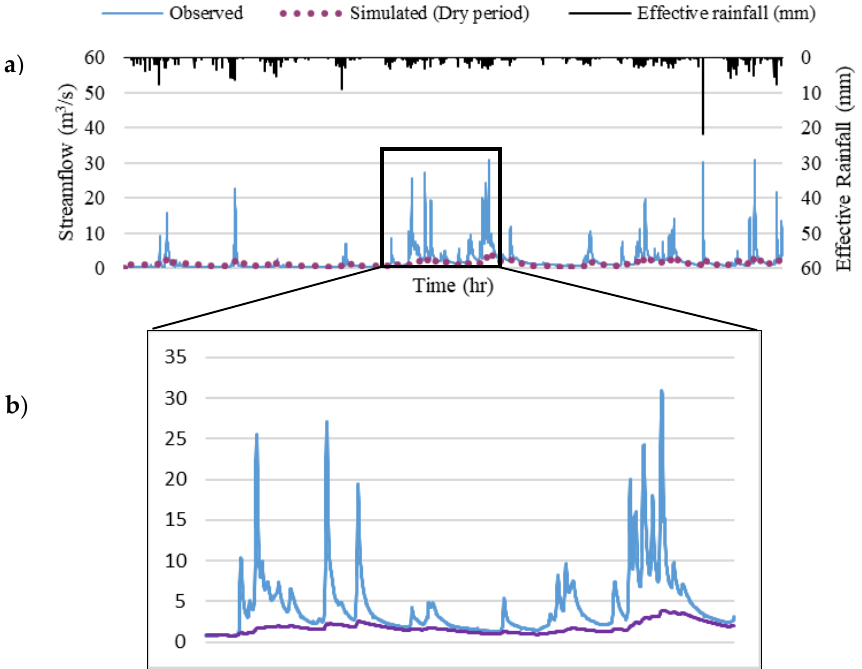
Figure 8. ( a ) Validation of the calibrated dry-period model; ( b ) zoomed in for a clear view.